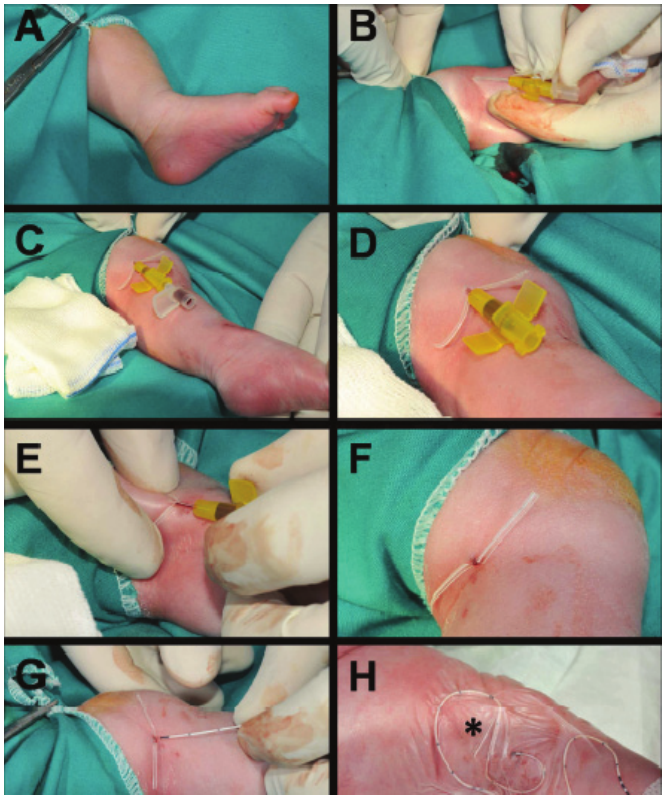
FIGuRE 2 - The insertion of the 2-F PICC by using pre-cut-semi-split introducer that prepared with our technique and transparent adhesive dressing with removed introducer ( asterisk ). 373x469mm (150 x 150